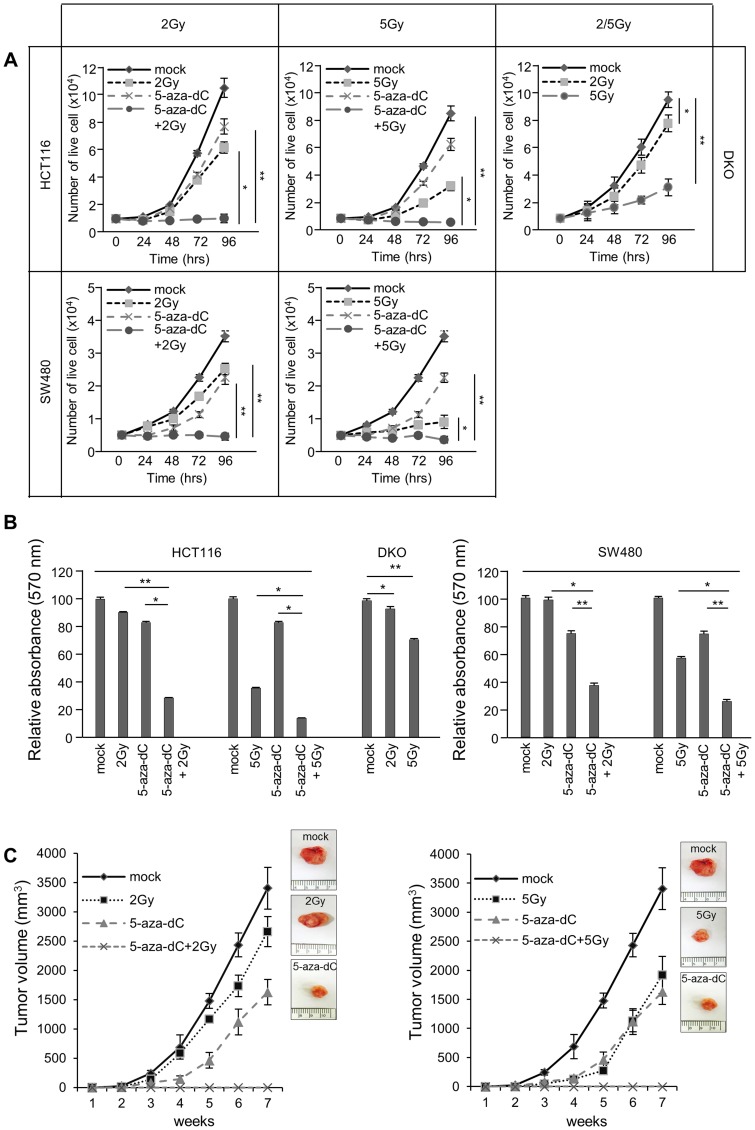
Growth inhibition in colon cancer cell lines in response to treatment with 5-aza-dC and irradiation.(A) Cell growth curves obtained using 0.5 µM 5-aza-dC and two different radiation doses (2 Gy and 5 Gy) in colon cancer cells (HCT116, DKO and SW480) and (B) MTT assays in colon cancer cells treated with 5-aza-dC (0.5 µM) and/or irradiation (2 Gy and 5 Gy). Data are expressed as the mean ± standard deviation of triplicate experiments. (C) Tumor growth following 5-aza-dC (0.5 µM) treatment and/or irradiation (2 Gy and 5 Gy) in SCID mice. HCT116 cells (5×106 cells) that had been treated with 5-aza-dC (0.5 µM) and irradiated (2 Gy and 5 Gy) were injected subcutaneously into SCID mice (n = 4), and the average tumor size was measured once weekly for 7 weeks. P-values were calculated using Student's t-test. *P<0.05; **P<0.01.